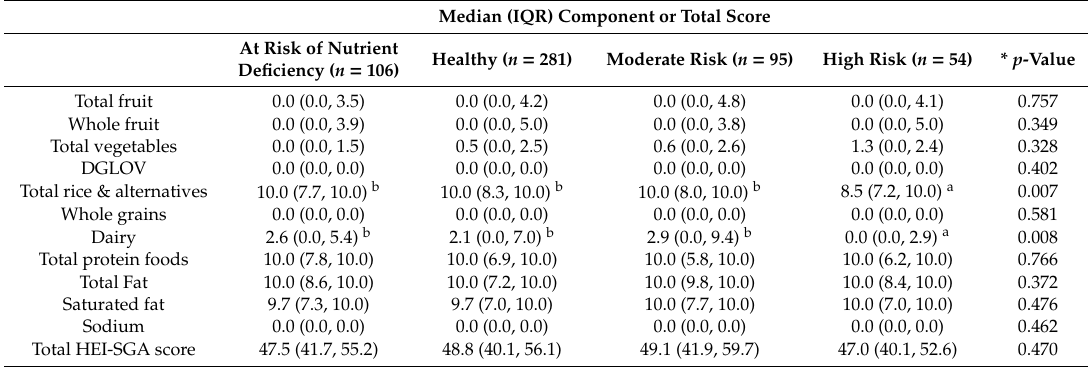
Table 3. Median component and total HEI-SGA values across all participants and by BMI category. Median (IQR) Component or Total Score At Risk of Nutrient Healthy ( n = 281) Moderate Risk ( n = 95) High Risk ( n = 54) * p -Value Deficiency ( n = 106) Total fruit